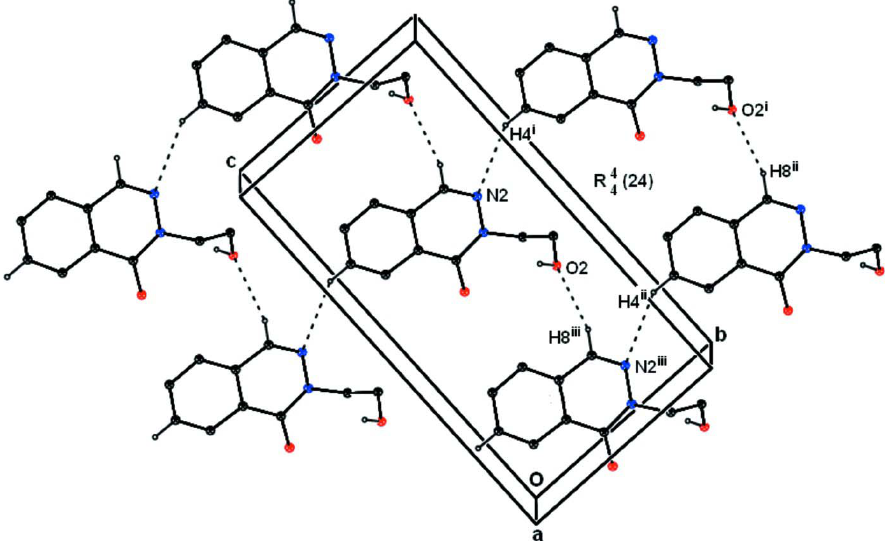
Figure 4 A partial packing diagram of (I), showing the formation of R 44 (24) ring motifs. Hydrogen bonds are shown as dashed lines [symmetry codes: (i) x, y + 1, z; (ii) 3/2 - x, y + 1, z - 1/2; (iii) 3/2 - x, y, z - 1/2]. H atoms not involved in hydrogen bondings have been omitted for